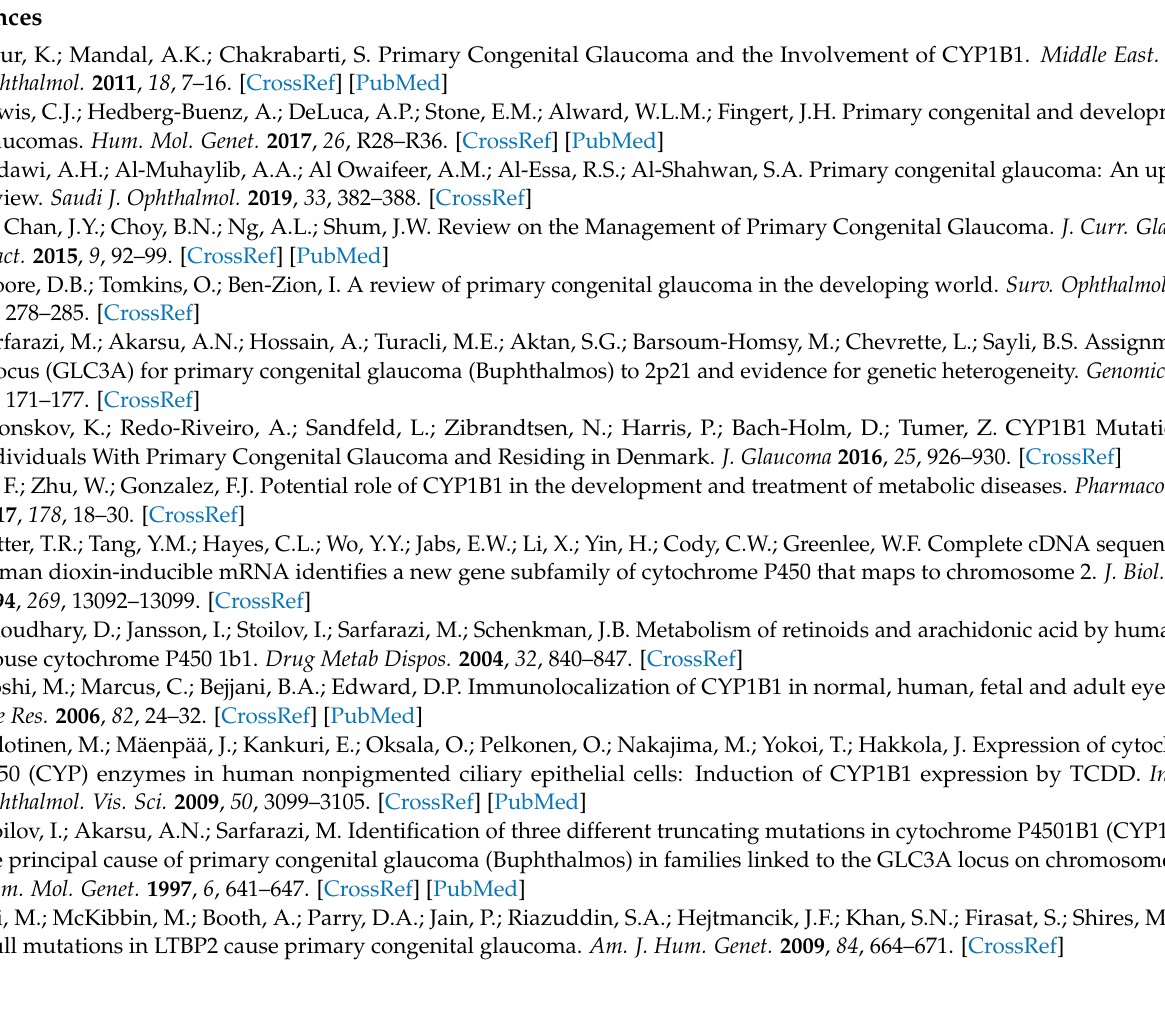
Table S2: List of papers